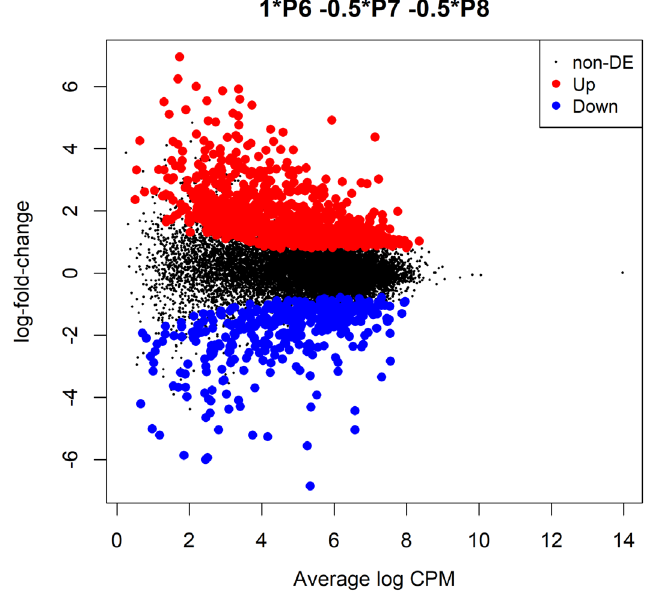
Figure 7. MD plot showing the log-fold-change of the methylation level and average abundance of CpG sites in each gene promoter. Significantly hyper and hypomethylated gene promoters are highlighted in red and blue,